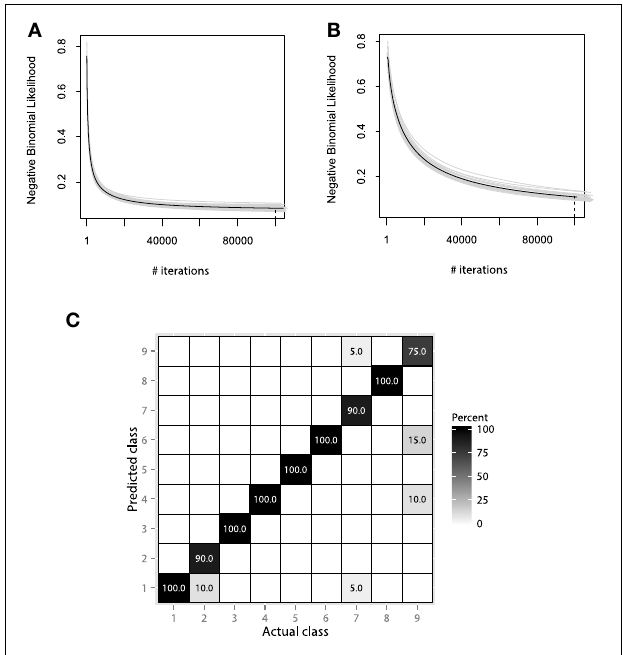
FIGURE 15 | (A) Bootstrap estimates of M for class 1 of CNAE, held-out error with λ = 0 . 01. (B) Bootstrap estimates of M for class 1 of CNAE, held-out error with λ = 0 . 001. (C) Confusion matrix for the CNAE-9 test set.